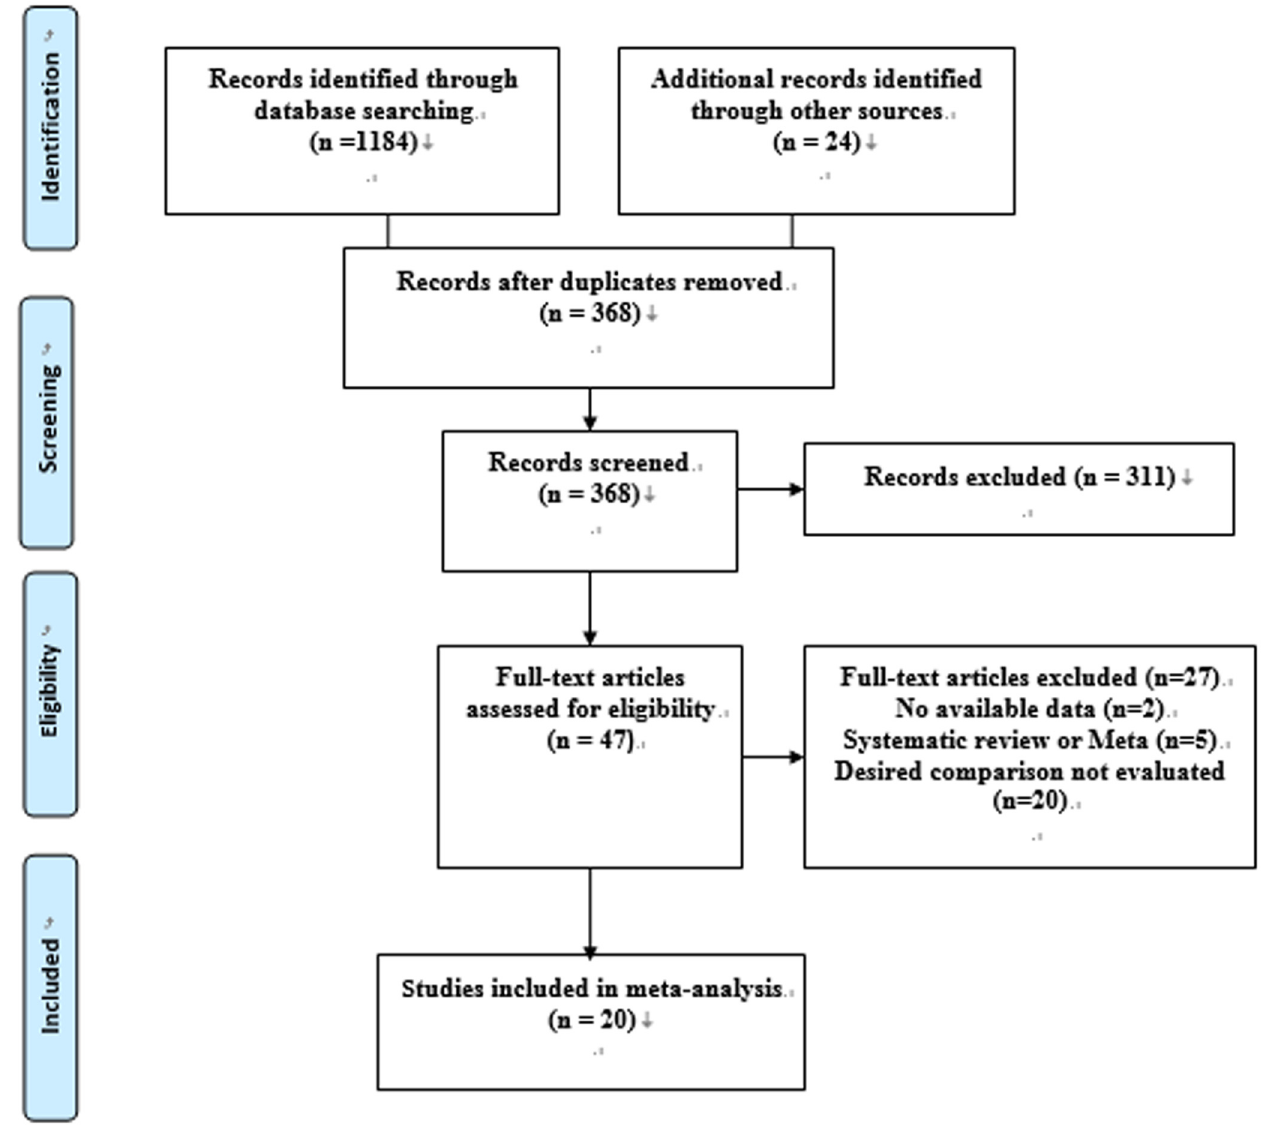
Fig 1. Flowchart of the selection of studies included in the